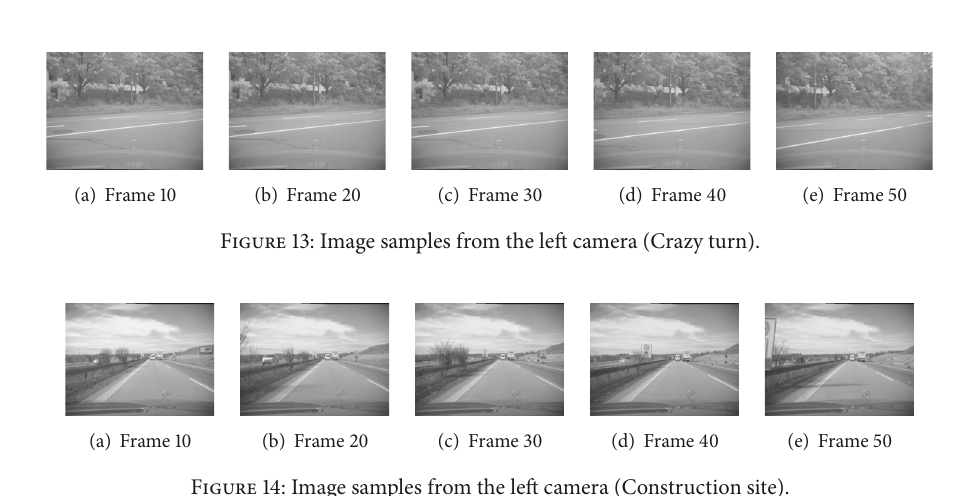
Figure 14: Image samples from the left camera (Construction site).